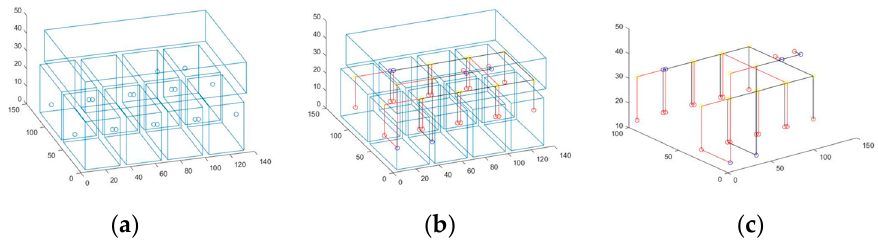
Figure 9. ( a ) The randomly generated layouts; ( b ) the routing results of our routing algorithm; ( c ) the final result of the bus connection.